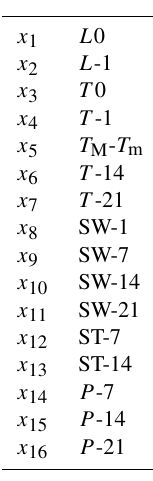
Table A2. The selected input regressors x i